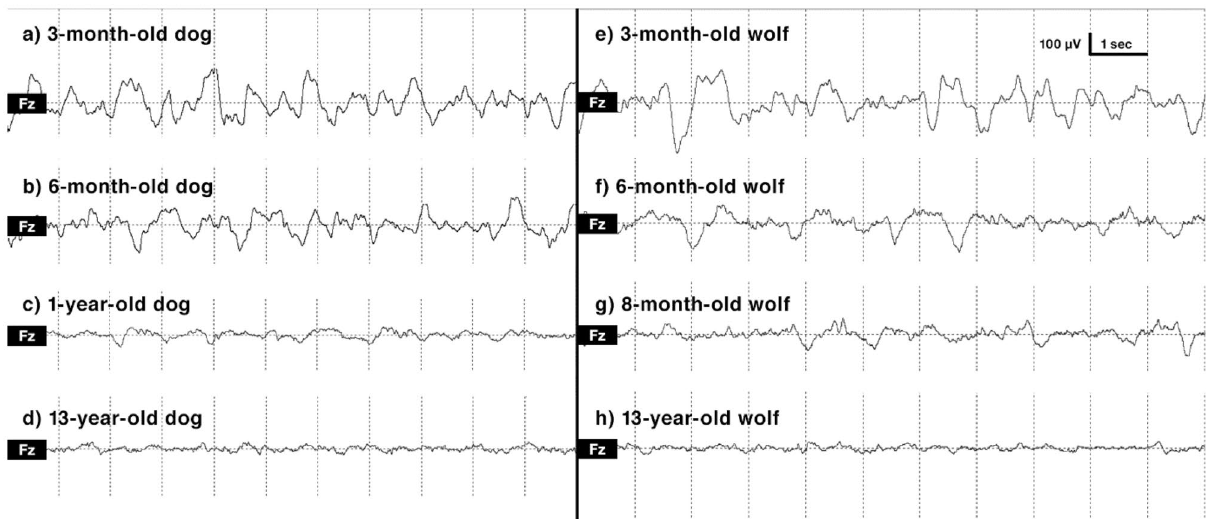
Figure 4. Representative EEG traces of NREM sleep from different ages of (a–d) dogs and (e–h) wolves. EEG traces of 6-month-old and 1-year-old dogs are from a previous dog polysomnography study 51